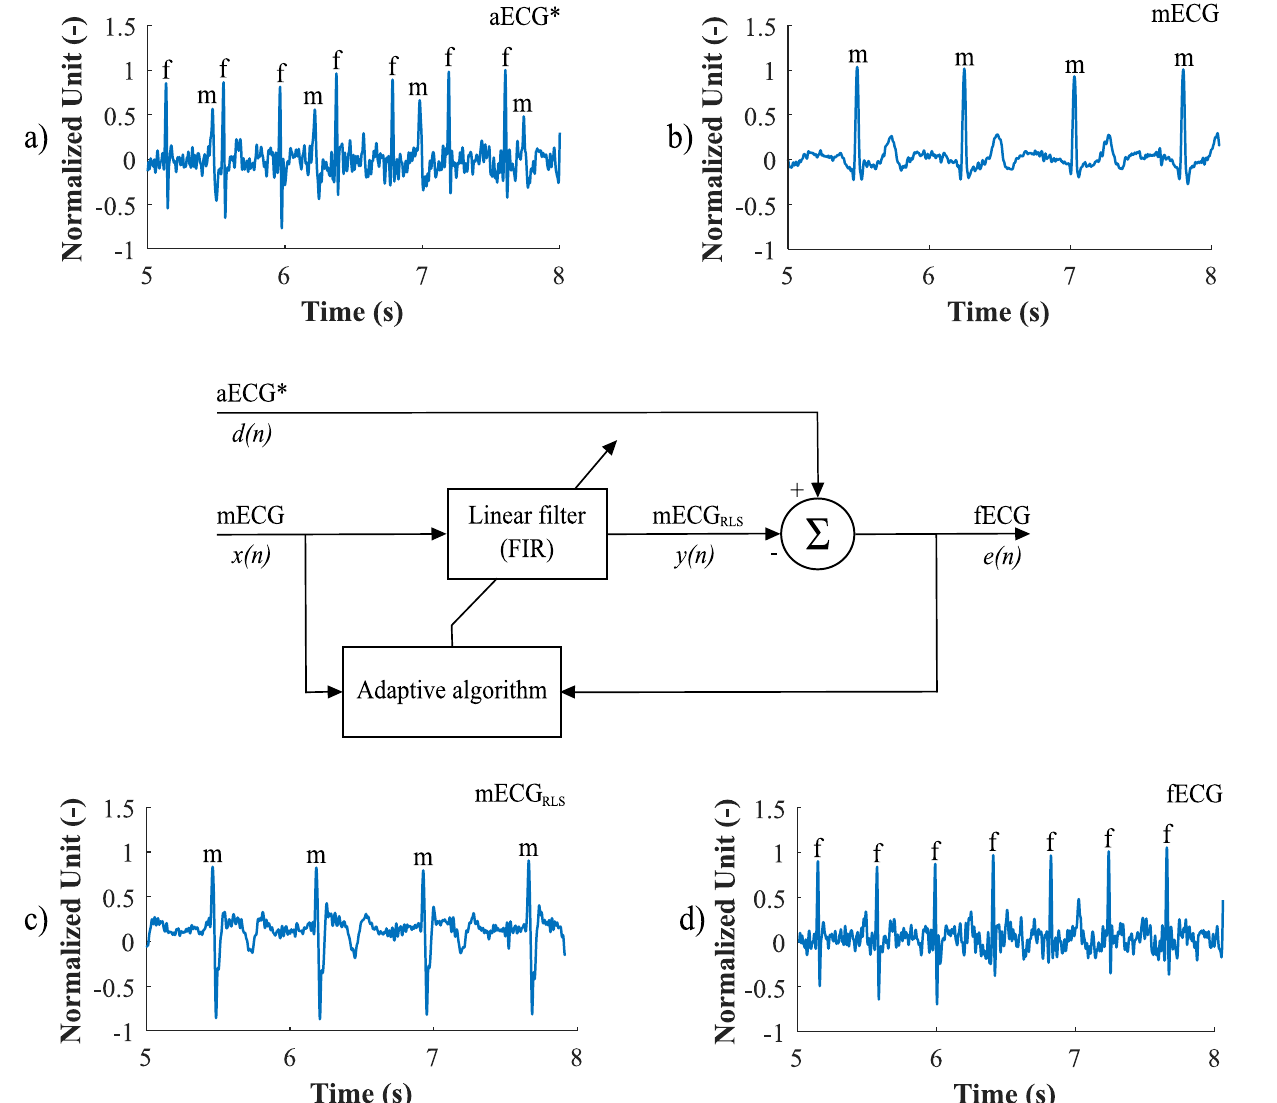
Fig 5. The RLS algorithm structure with examples of the input and output signals: a) aECG � signal, referred to as primary input or desired signal d ( n ), b) mECG signal that needed to be adjusted by an adaptive filter, denoted as x ( n ). Example c) represents an mECG RLS component that has been adjusted by the filter into a shape of the mECG component in the aECG � signal, denoted as y ( n ). This modified mECG RLS signal was subtracted from the aECG � signal, thus generating the fECG signal, denoted as error signal e ( n ).